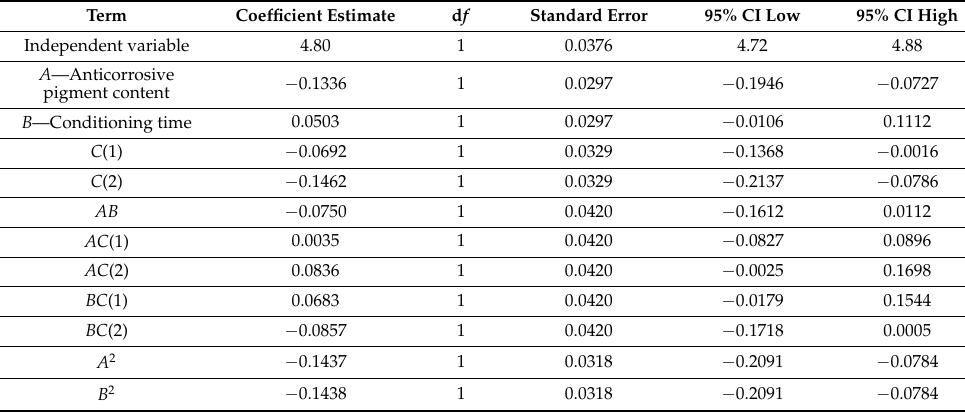
Table 6. Standard errors of regression coefficients-adhesion force.